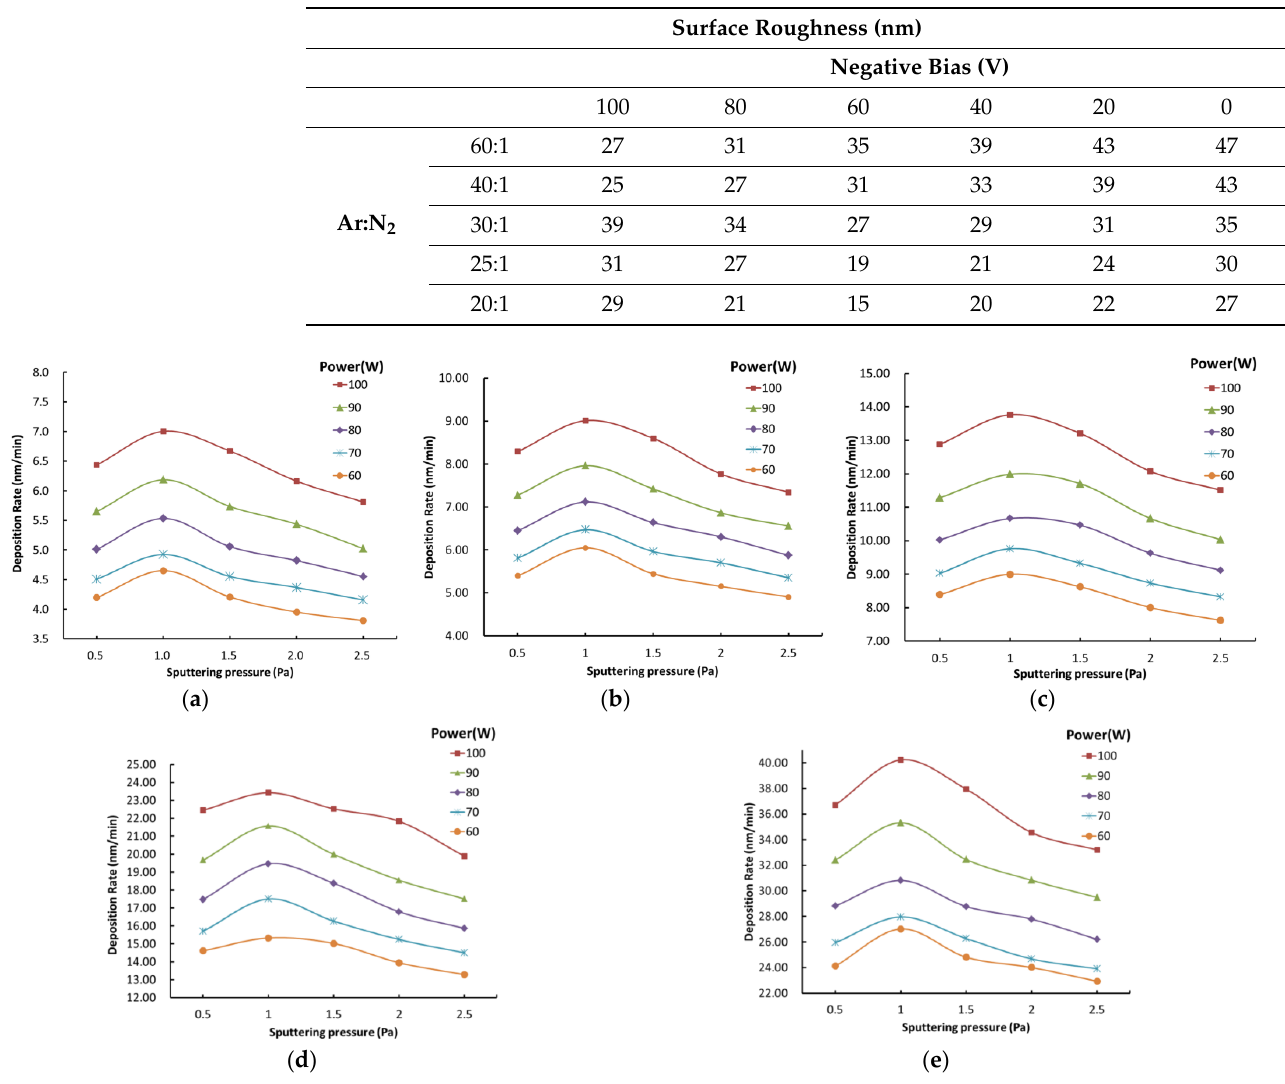
Table 12. Effect of process parameters on surface roughness Ra of TiN film.